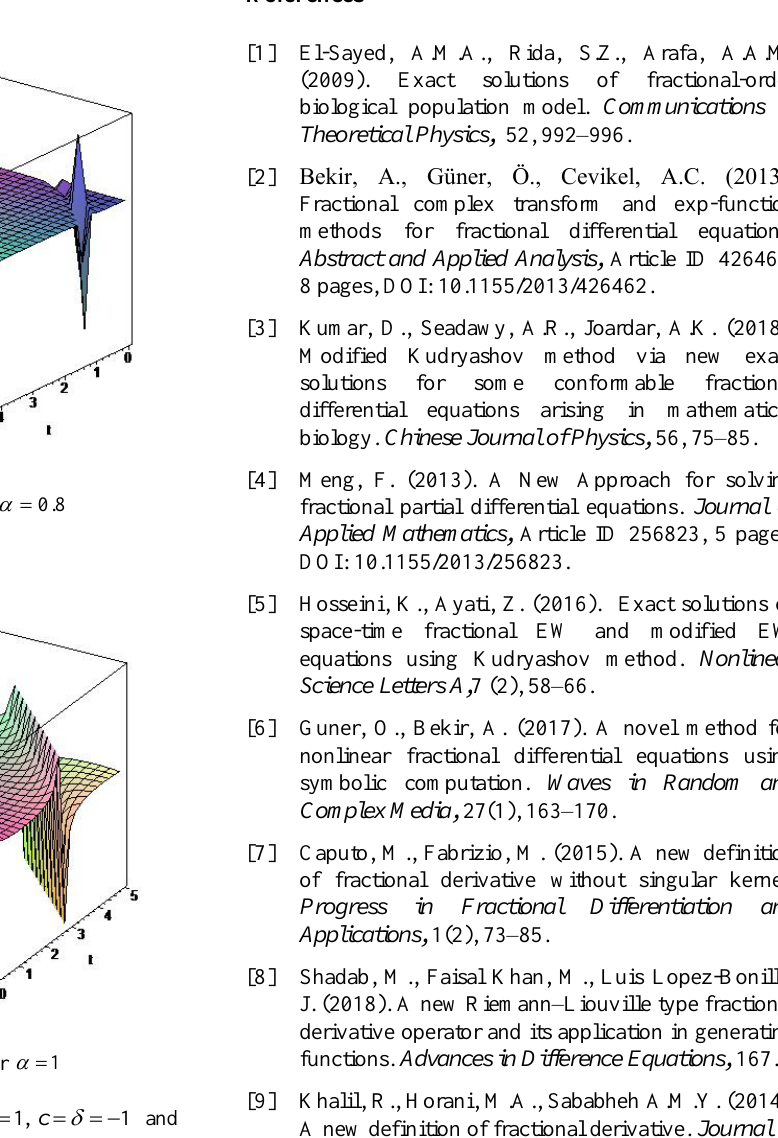
Figure 5. Solution Eq.(33) for 1, 1 k c  = = = = − and indicated 